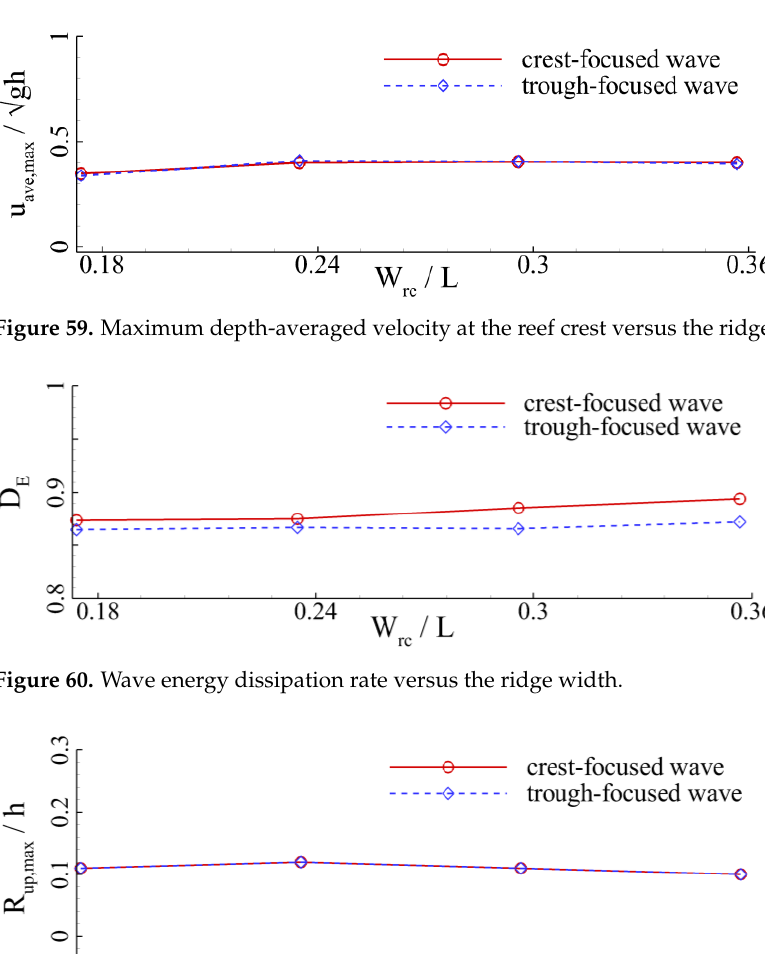
Figure 58. Space distribution of the local maximum depth-averaged velocity.